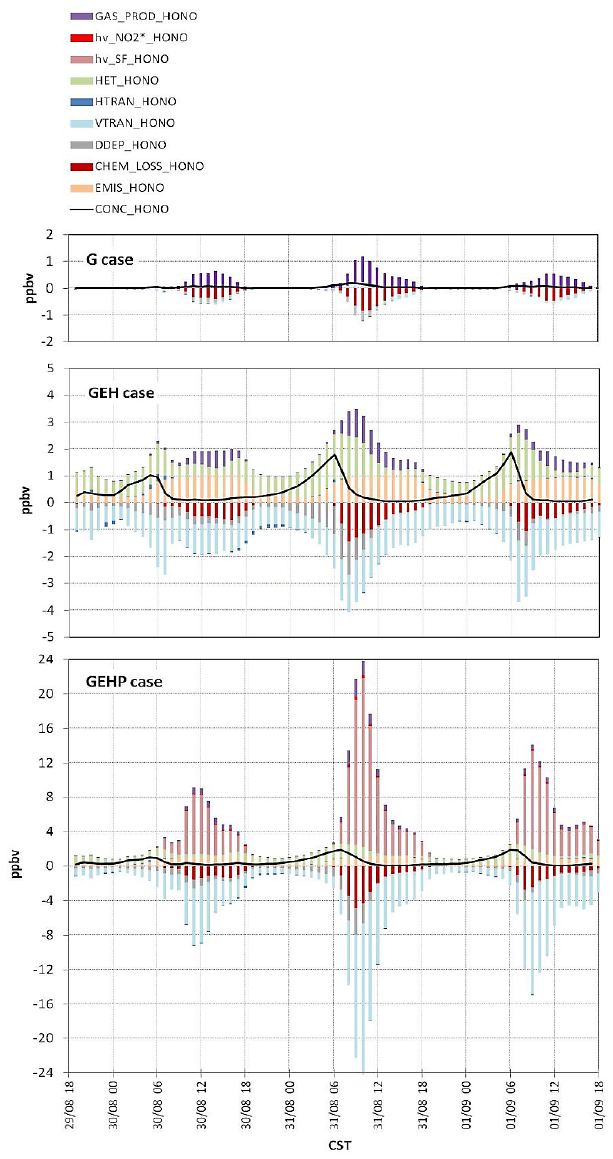
Fig. 9. HONO mixing ratio (black line) in ppbv and contribution of different processes to changes in HONO mixing ratios (columns) for G case (top), GEH case (middle), and GEHP case (bottom) in the first model layer (0–34m a.g.l.). Note that the scale is differ- ent in the graphs. GAS PROD HONO represents OH+NO reaction producing HONO, hν NO2 ∗ HONO is HONO formed from ex- cited NO 2 , hν SF HONO–is photochemical production of HONO on surfaces, HET HONO represents change in HONO mixing ra- tio due to heterogeneous chemistry, VTRAN HONO–vertical trans- port, HTRAN HONO–horizontal transport, DDEP HONO–dry de- position, CHEM LOSS HONO–oss of HONO by gas phase chem- ical reactions, EMIS HONO–emissions.